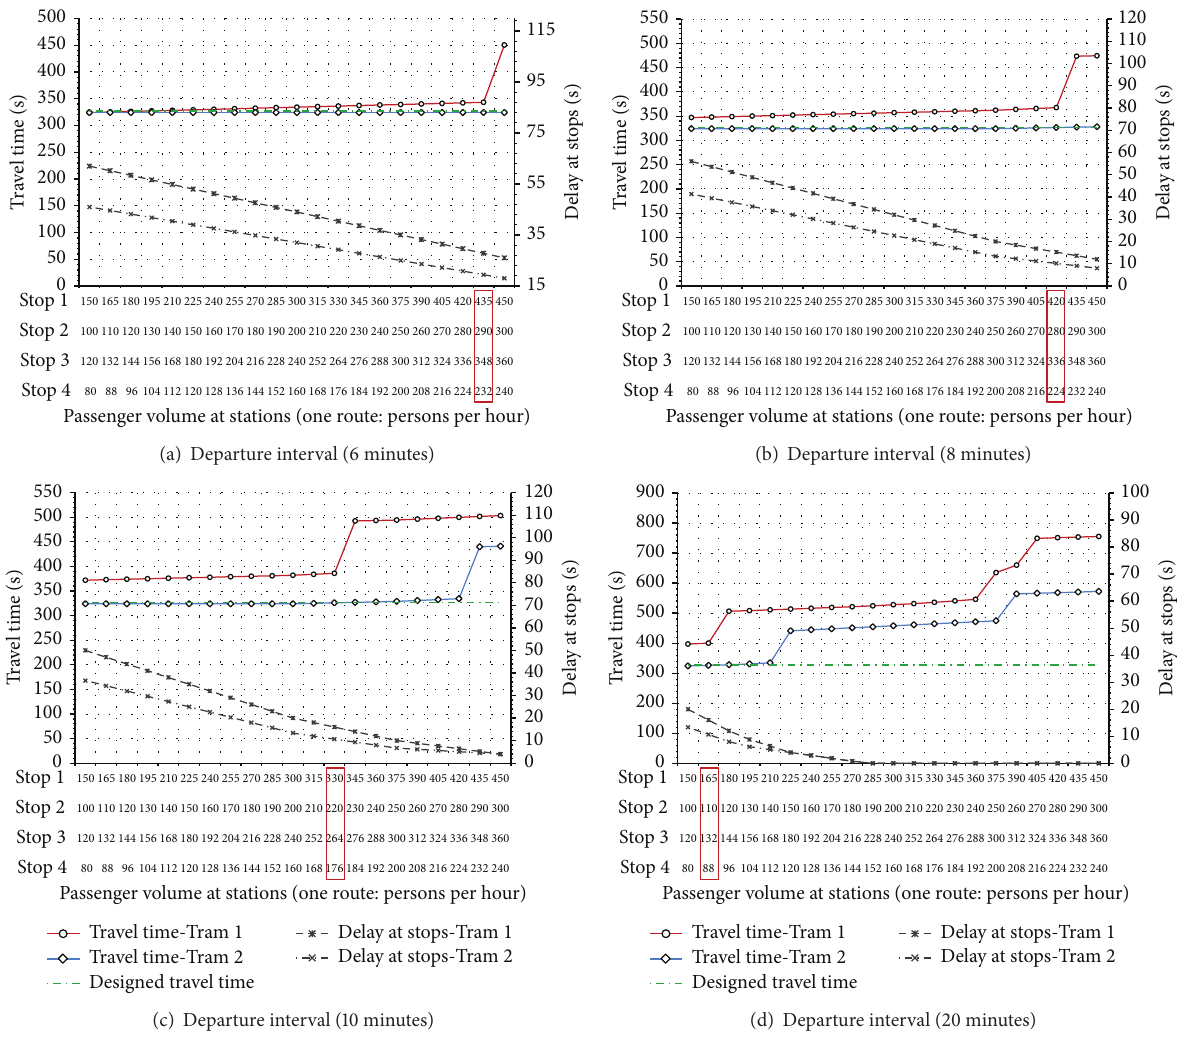
Figure 6: Impacts of passenger flows on streetcars